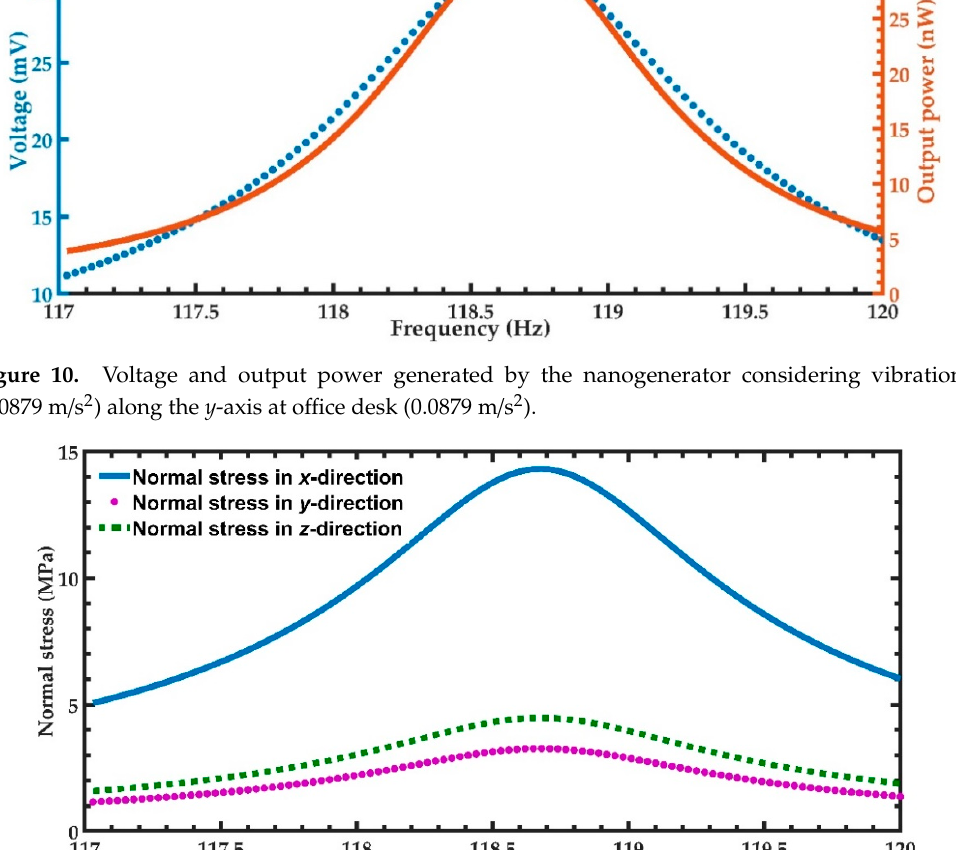
Figure 11. Maximum normal stresses of the nanogenerator considering an acceleration in y -direction of 0.0879 m/s 2 and a frequency range from 117 to 120 Hz.